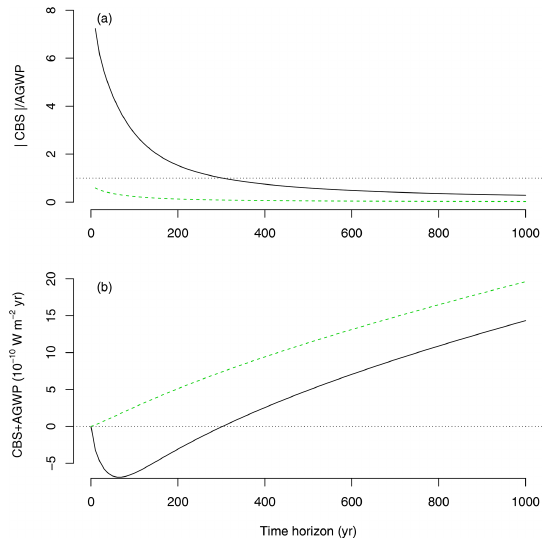
Figure 6. Relations between CBS and AGWP for the IRF PD100 as a function of time horizon T . (a) Ratio between the absolute value of CBS and AGWP, based on a total sequestration of 12.3Mg of carbon (back line, GPP equivalent for 1ha and 1 year at Duke For- est) versus a sequestration of 1Mg of carbon (dashed green line). (b) Radiative balance (net difference) between CBS and AGWP for the sequestration of 12.3Mg of carbon (black line) and 1Mg of car- bon (dashed green